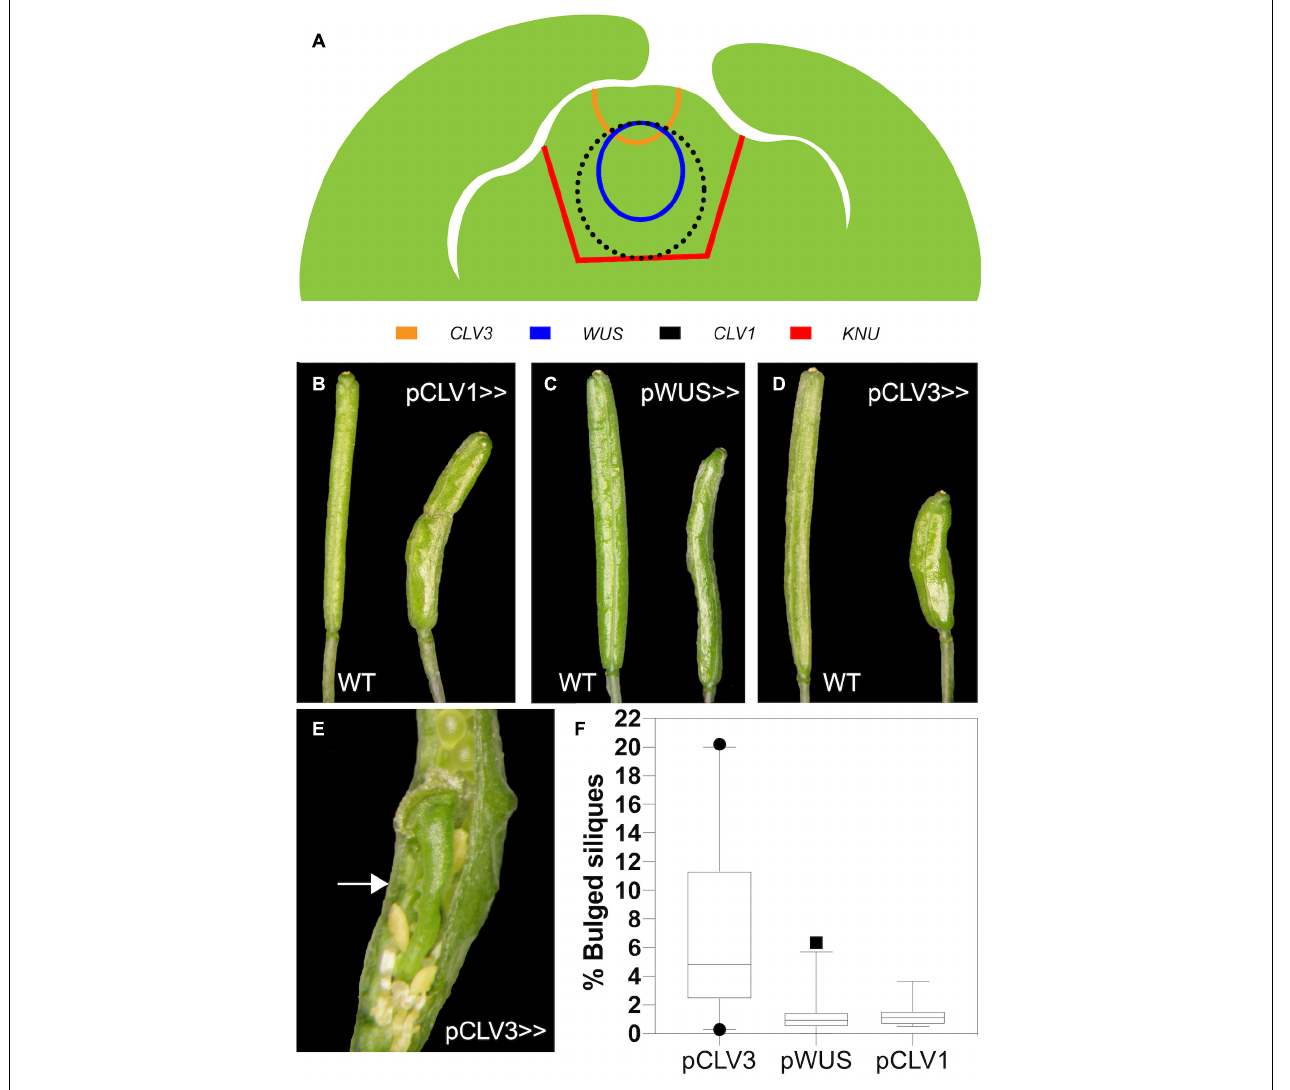
FIGURE 6 | Effects of expression of the KNU-amiRNA from different driver lines. (A) Schematic of a cross-section of a stage 5 floral bud. The approximate expression domains of KNU , CLV1 , CLV3 , and WUS are indicated. (B–D) Siliques of the wild-type (on the left) and of driver lines (on the right) for CLV1 (B) , WUS (C) and CLV3 (D) expressing the KNU-amiRNA1. (E) Silique of a plant expressing the KNU-amiRNA from the CLV3 driver. An arrow marks an ectopic gynoecium. Ectopic stamens are also visible. Part of a valve has been removed to reveal the internal structures. (F) Quantification of phenotypic effects. The percentage of siliques with bulges was determined in lines expressing the KNU-amiRNA from the different driver lines (as indicated). Black dots and a square indicate outliers. Data are based on the analysis of at least 16 independent transformants per driver